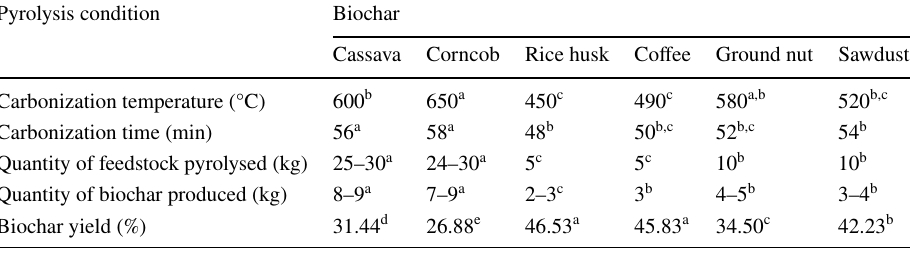
The letters in superscript compare the means of the different biochars. The same letters in a row are not sig- nificantly different according to Tukey at P